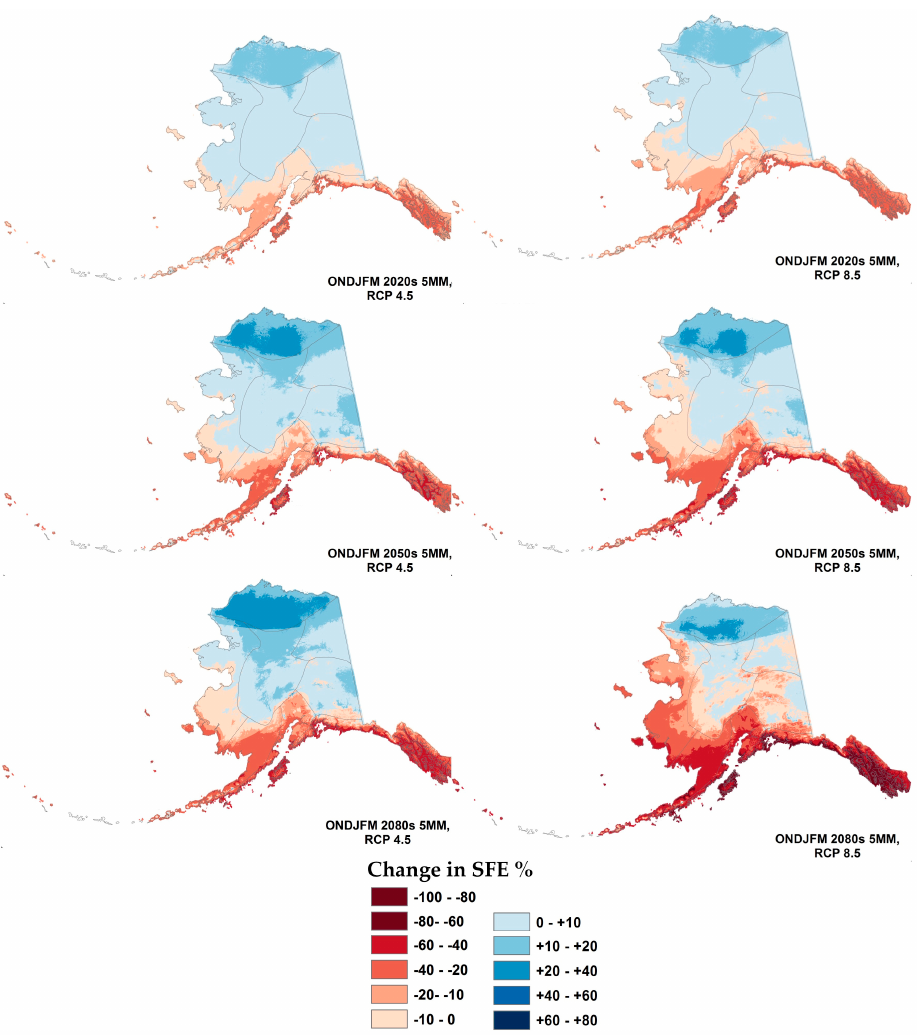
Figure 4. 2020s ( top ), 2050s ( middle ), and 2080s ( bottom ) changes in five-model mean projected October–March SFE for RCP 4.5 ( left ) and RCP 8.5 ( right ). Climate division boundaries appear as gray lines.